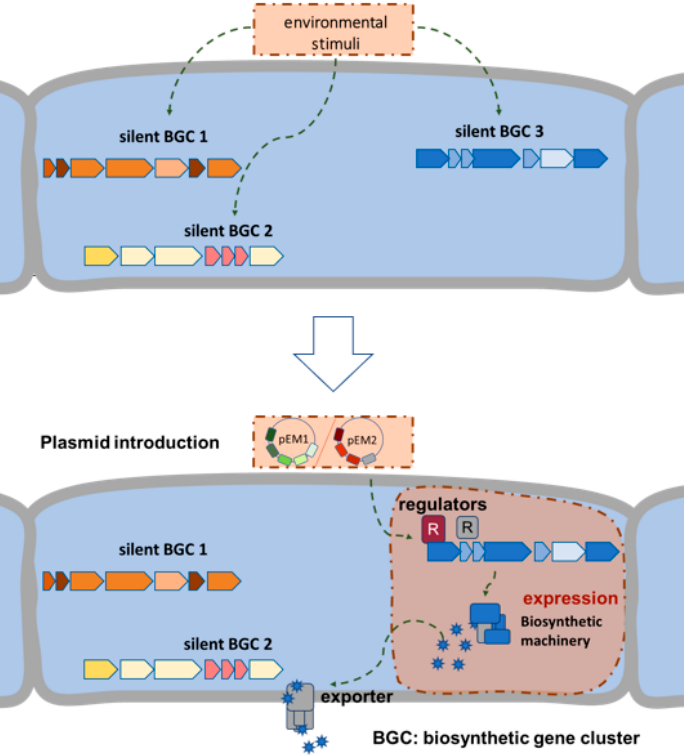
Figure 1. Scheme of the “semi-targeted” approach to activate silent BGCs in Actinomyces . pEM1, plasmid carrying different cluster situated regulator genes (CSRs); pEM2, plasmid carrying genes encoding different Streptomyces antibiotic regulatory proteins (SARPs).